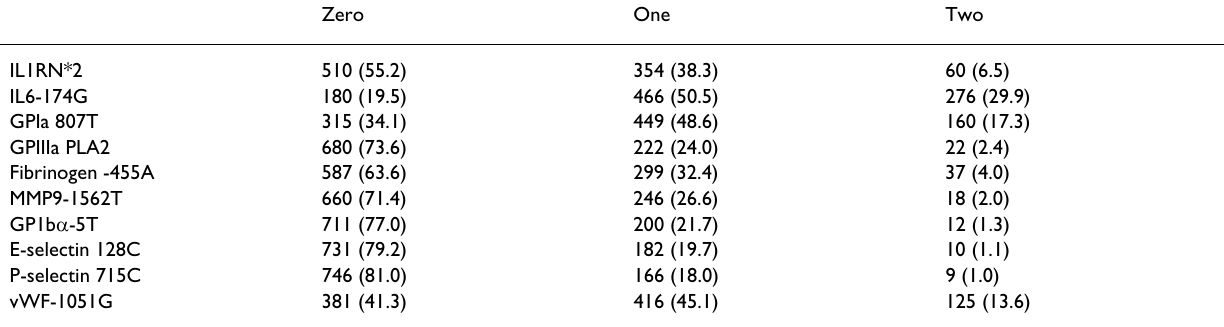
Table 2: OPUS TIMI-16 study: Distribution of genotypes n (%) Zero One